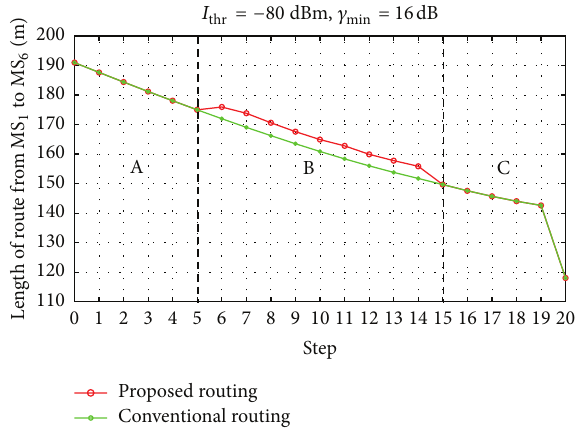
Figure 12: Length of the route from MS 1 to MS 6 using the proposed routing protocol and the conventional routing protocol.